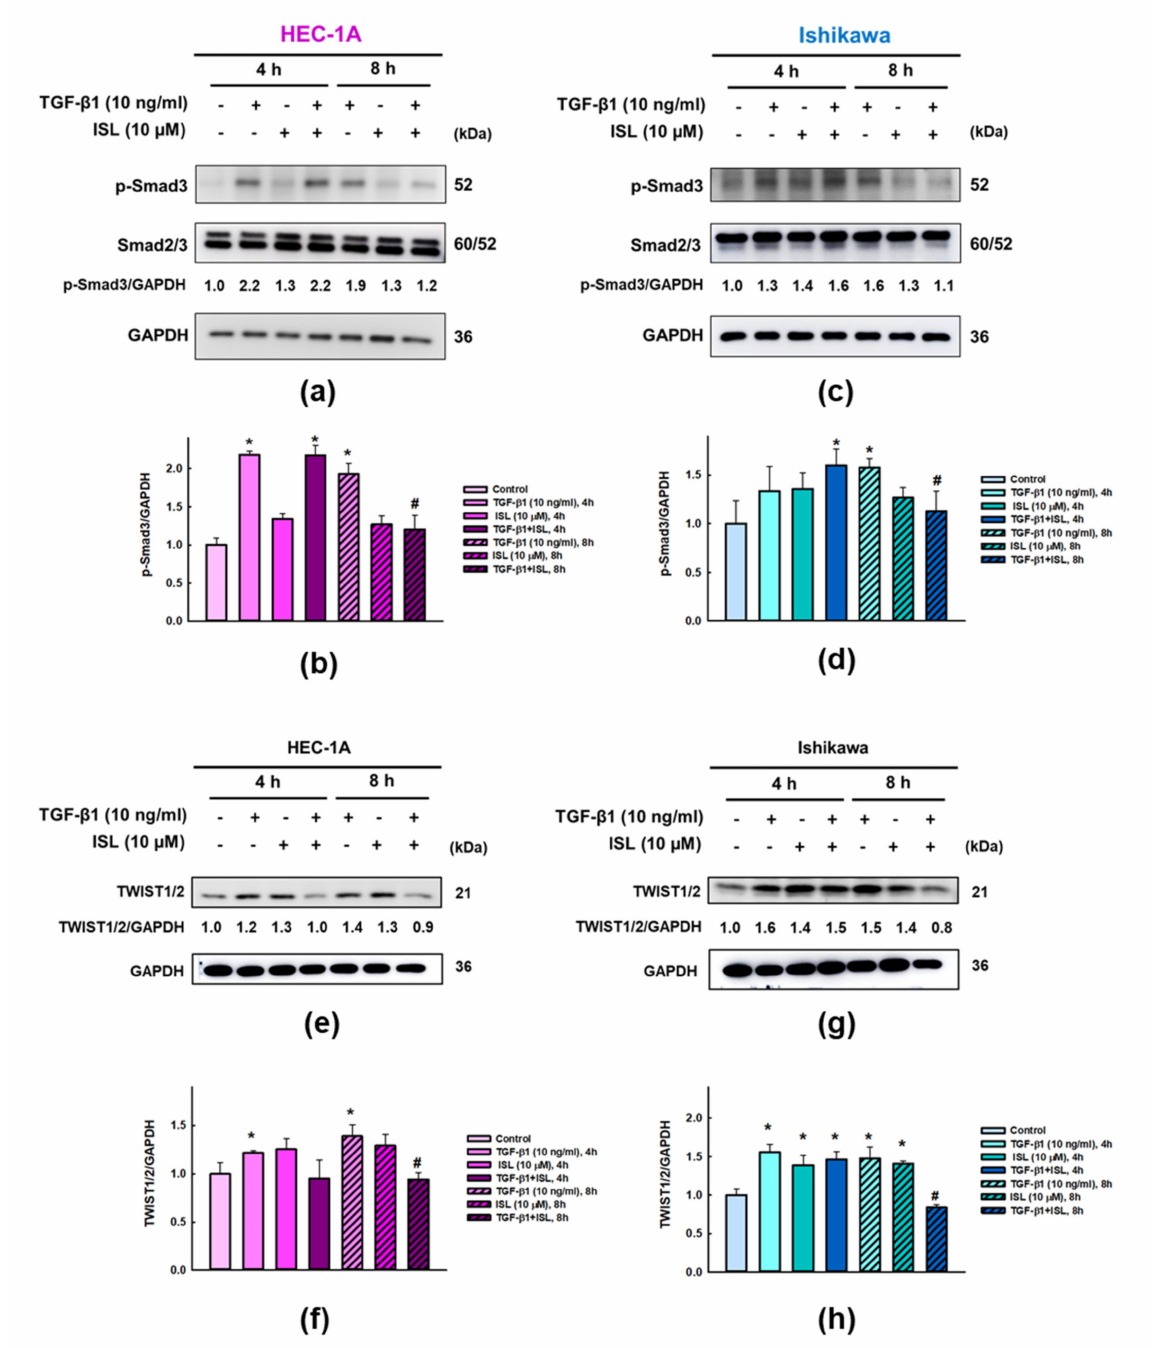
Figure 6. Effect of ISL on expression of TGF β -/Smad Signaling Pathway related markers in human Endometrial Cancer Cells. HEC-1A ( a , e ) and Ishikawa ( c , g ) cells were treated with TGF- β 1 (10 ng/mL) and ISL (10 µ M) for 4 h and 8 h. Cell lysates were separated by SDS-PAGE and detected by western blotting with the anti-p-Smad3, Smad2/3, and TWIST1/2. Each target protein was normalized to GAPDH and protein quantification was shown in bar graph ( b , d , f – h ). The values were expressed as the mean ± SD ( n = 3). * p < 0.05, versus the vehicle control. # p < 0.05, versus the TGF- β 1